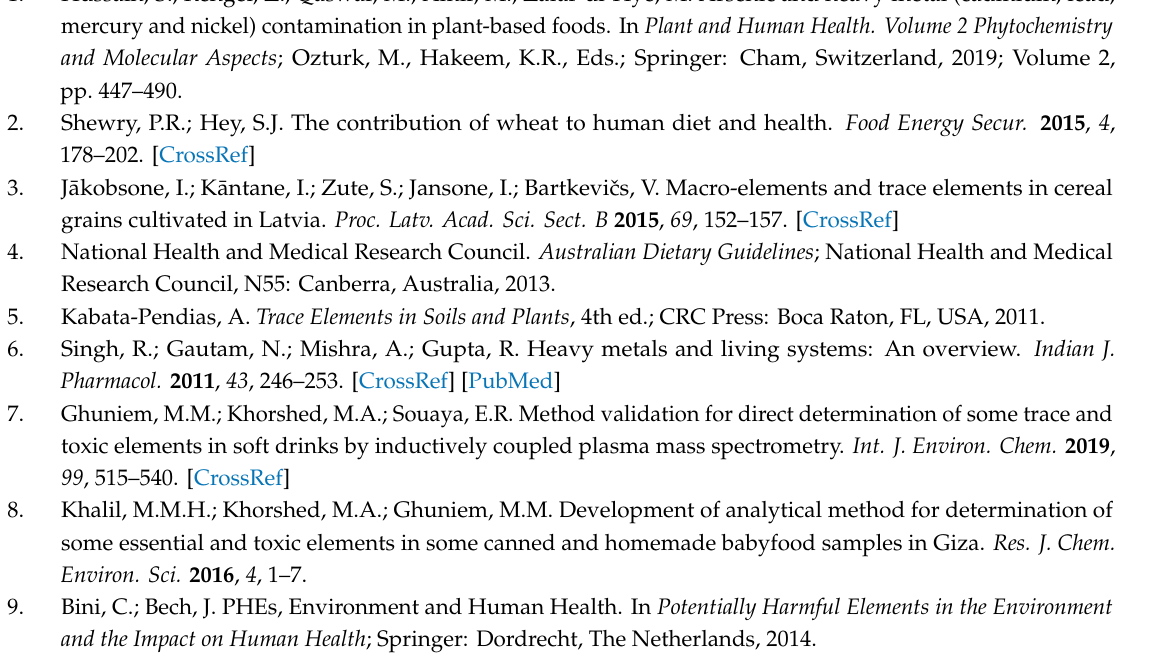
Table S1: PHE contents in arable soils in southern Poland (based on [1,2]) used for soil-to-plant transfer indices in this study, Figure S1. Ordination diagram of PCA, computed for the PHE contents in cereals samples. Figure S2. Dendogram of PHEs in cereals, according to Sneath’s criteria. Figure S3. The color-scale map of standardized PHE contents in cereals